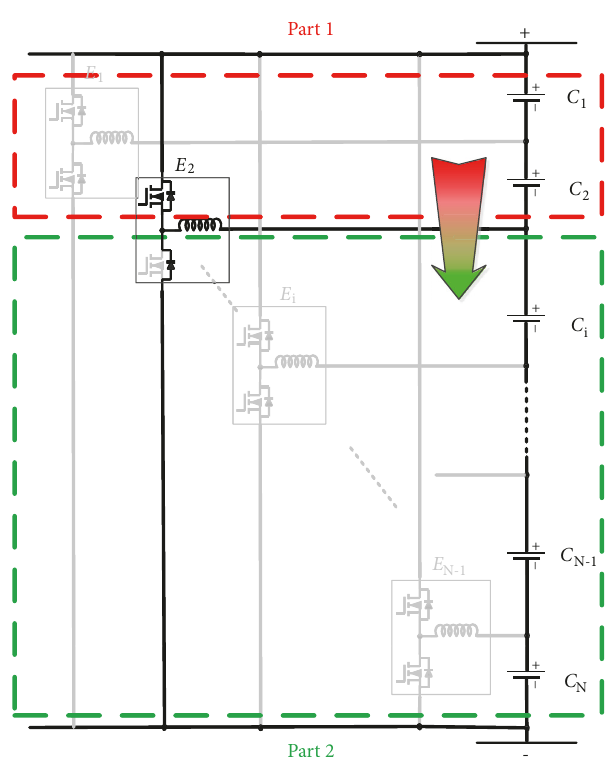
Figure 3: Energy transfer from Part 1 to Part 2, caused by E 𝑛